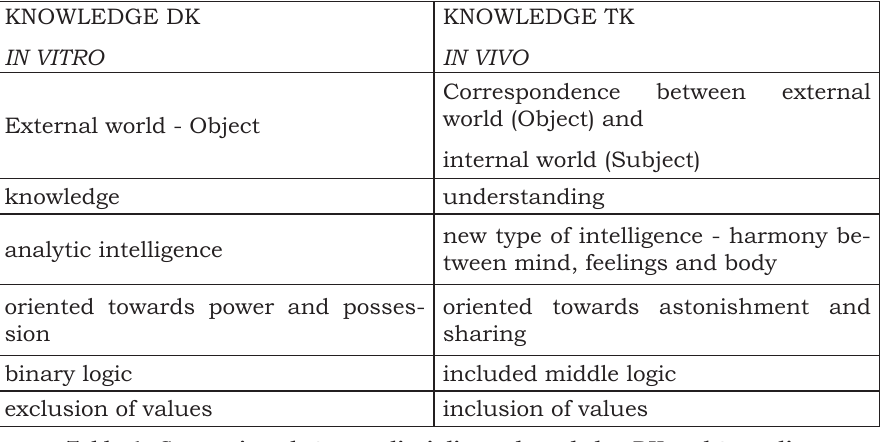
Table 1. Comparison between disciplinary knowledge DK and transdis- ciplinary knowledge